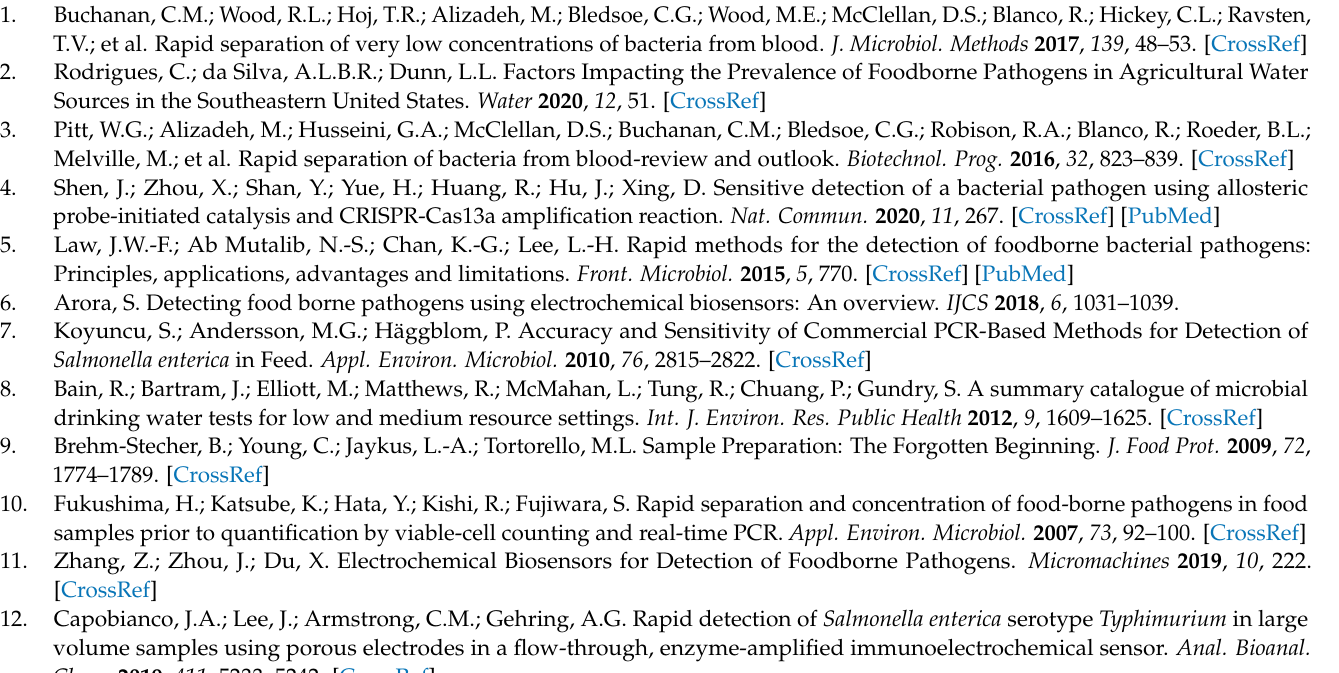
on the right y-axis are associated with the raw electrochemical signal; Figure S2: Comparison of normalized and raw colorimetric data for the detection of the DNA fragment. The values on the left y-axis correspond to the normalized response while those on the right y-axis are associated with the absorbance signal; Figure S3: Comparison of normalized and raw electrochemical data for detection of DNA from live Listeria monocytogenes cells. The values on the left y-axis correspond to the normalized response while those on the right y-axis are associated with raw electrochemical signal; Figure S4: Comparison of normalized and raw colorimetric data for detection of DNA from live L. monocytogenes cells. The values on the left y-axis correspond to the normalized response while those on the right y-axis are associated with the absorbance